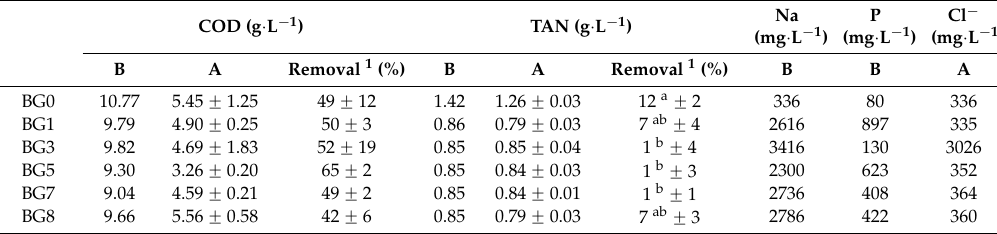
Table 7. Characteristics of the substrate before (B) and after (A) BMP